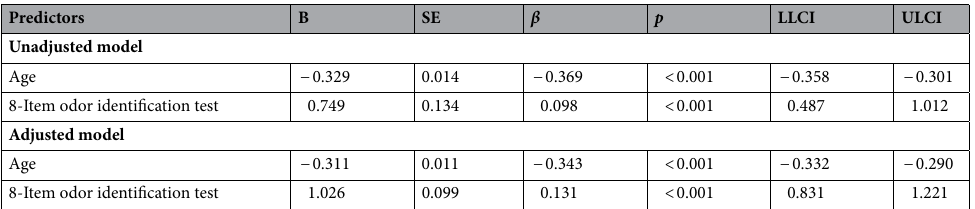
Table 2. Association between age and 8-item odor identification test score and absolute handgrip strength. Adjusted model: sex, race/ethnicity, ratio family income to poverty, marital status, education level, body mass index, dietary intake, smoking status, alcohol consumption and self-reported chronic